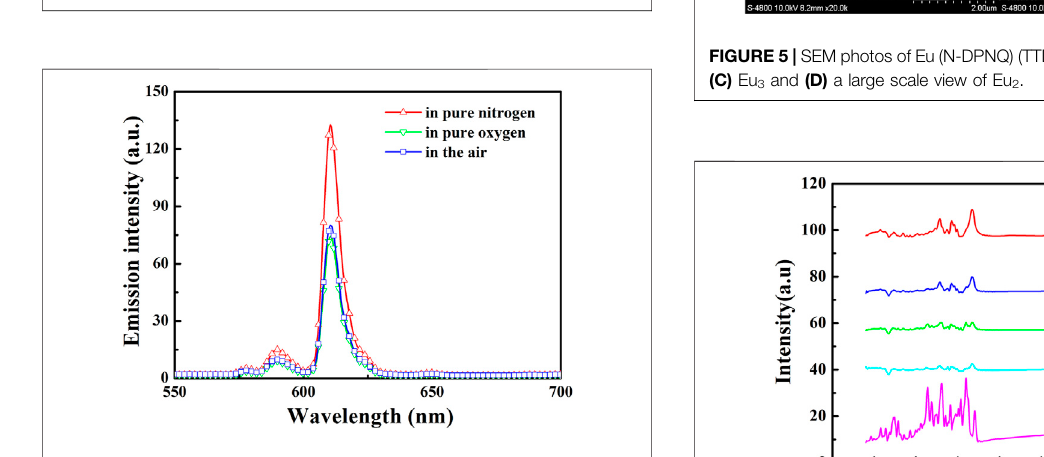
FIGURE 4 | PL spectra of Eu (N-DPNQ) (TTD) 3 upon various conditions. Excitation (cid:2) 365 nm.